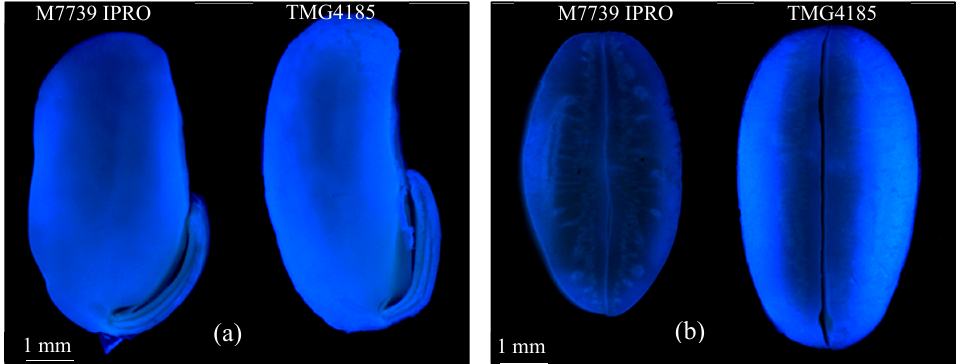
Figure 1. Fluorescence microscopy image of coumarin 120 uptake in low (M7739 IPRO) and high (TMG4185) soybean seed coat permeability varieties: respectively, ( a ) longitudinal section; ( b ) cross-section.